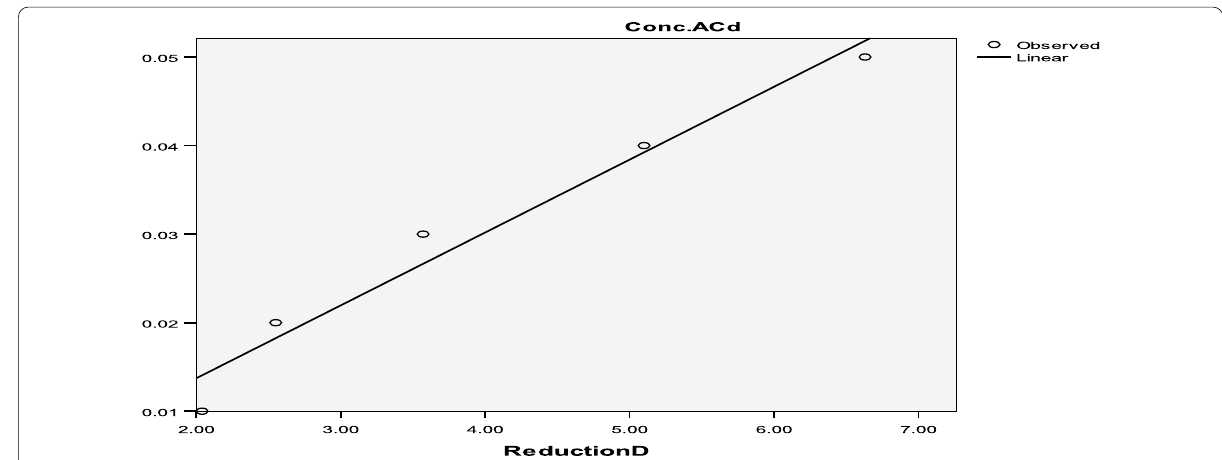
Fig. 2 Correlation between conc. of AC from DS and percentage reduction in methylene blue in wave length of 390